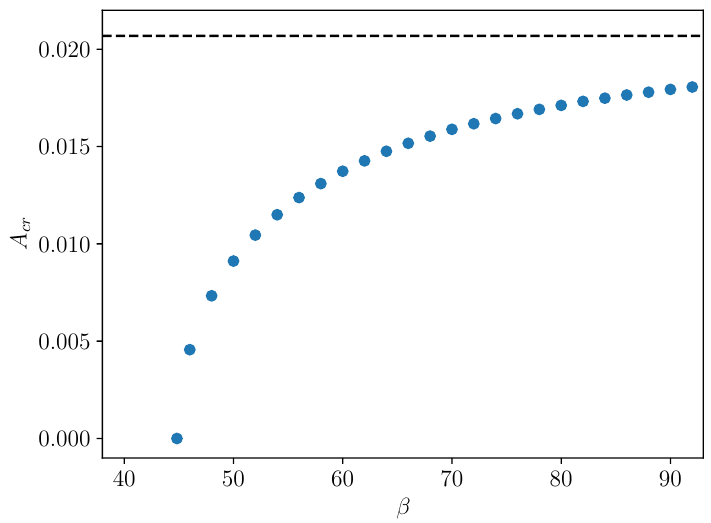
Figure 9 . Critical amplitude of the shape mode as a function of the back-reaction coupling constant β